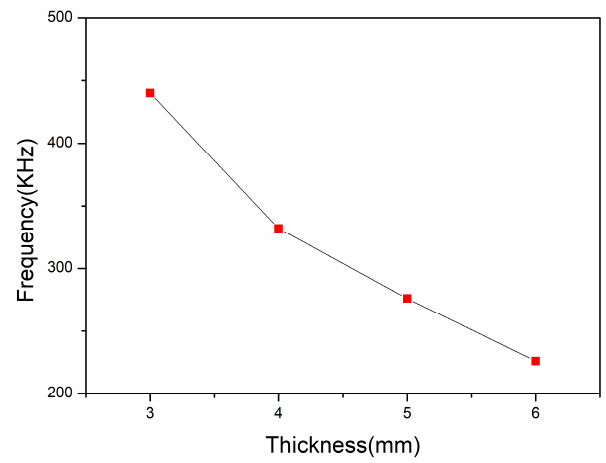
Figure 3. The variation curve of thickness resonance frequency with ceramic thickness.